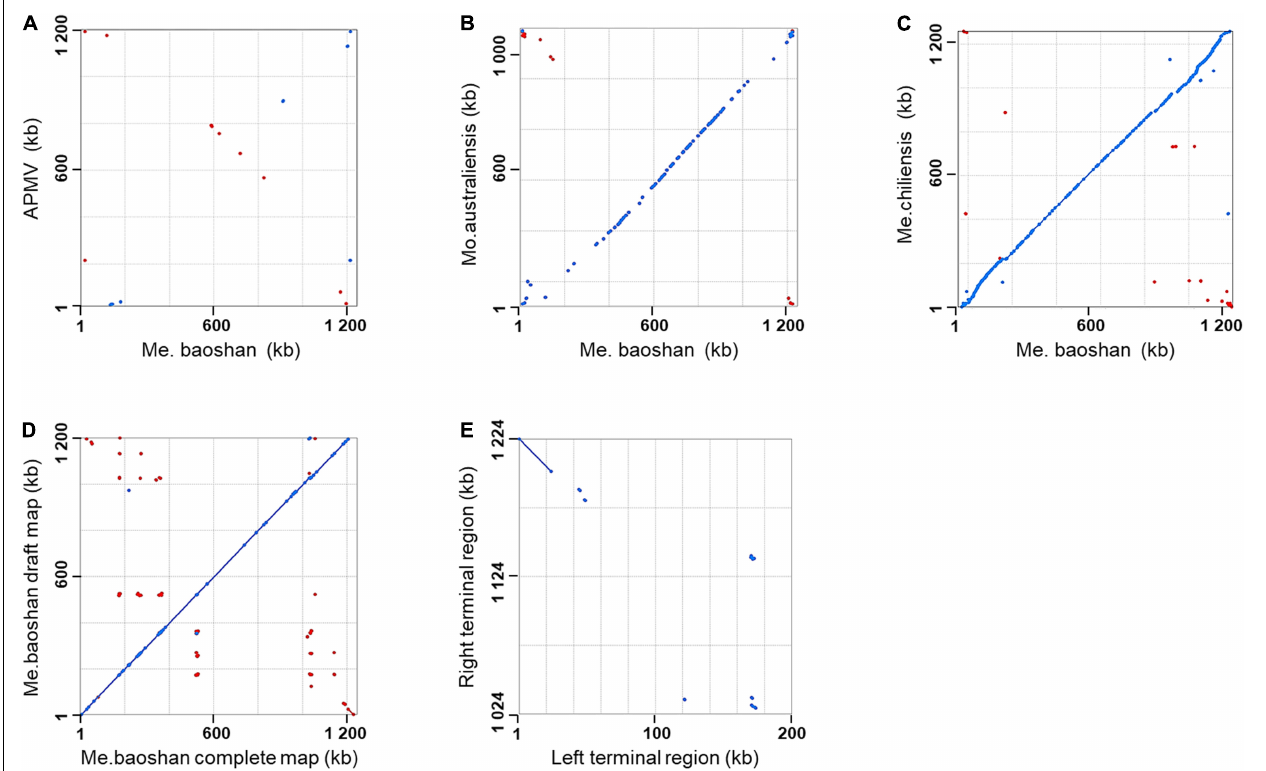
FIGURE 1 | Synteny analysis of Me. baoshan complete genome with (A) APMV, (B) Mo. Australiensis, (C) Me. chiliensis, and (D) draft map of Me. baoshan. (E) Terminal region comparison between left and right terminal region of Me. baoshan genome. Each dot symbolized the best Mummer match between the regions of the two viruses in the same orientation (blue) or in reverse orientation (red).